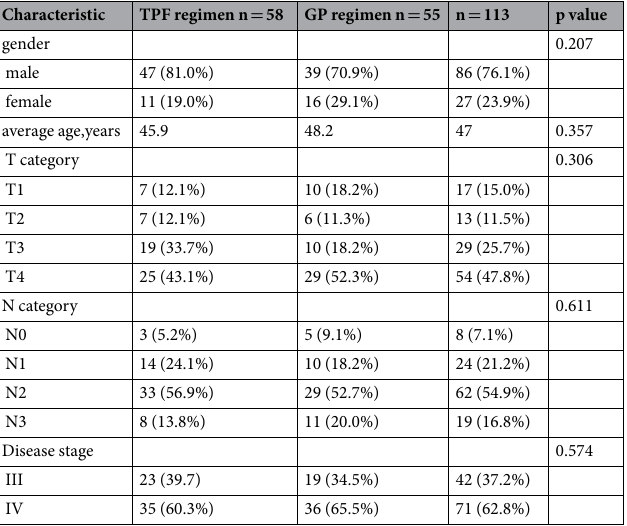
Table 1. Baseline characteristics of the 113 patients receiving TPF and GP treatment